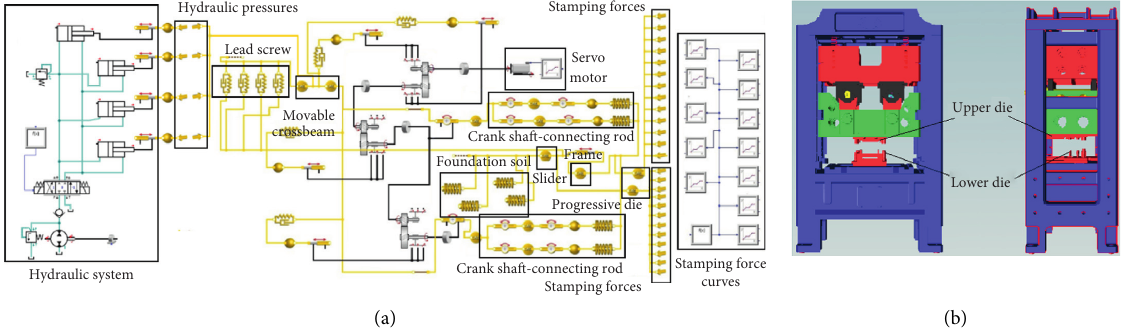
Figure 3: Multidomain model of high-speed punching press: (a) component structure of multidomain model of punching press; (b) 3D view of multidomain model.